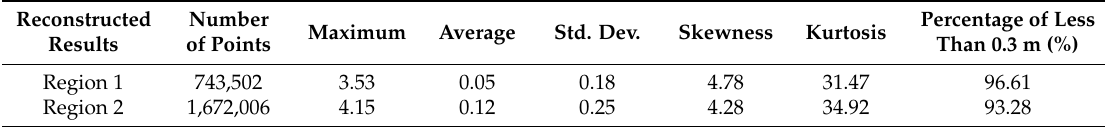
Figure 10. Deviation distances between the reconstructed building roof models and the LiDAR-derived validation data, as represented by points with different colors: ( a ), ( b ) Region 1 and Region 2, respectively. Table 3. Deviation distances of the reconstructed building roofs.